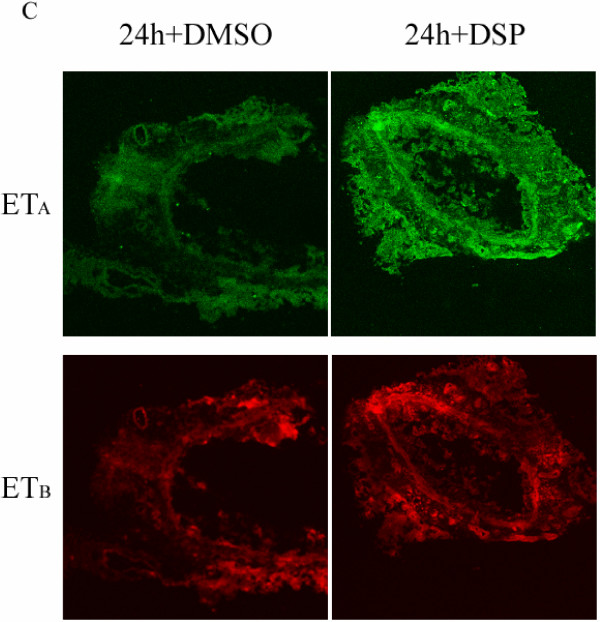
Immunostaining of ETA and ETB receptor protein in bronchi. Figure C. Example of immunostaining of ETA and ETB receptor protein after 24 h of culture together with DMSO as compared with 24 h of culture together with DSP.